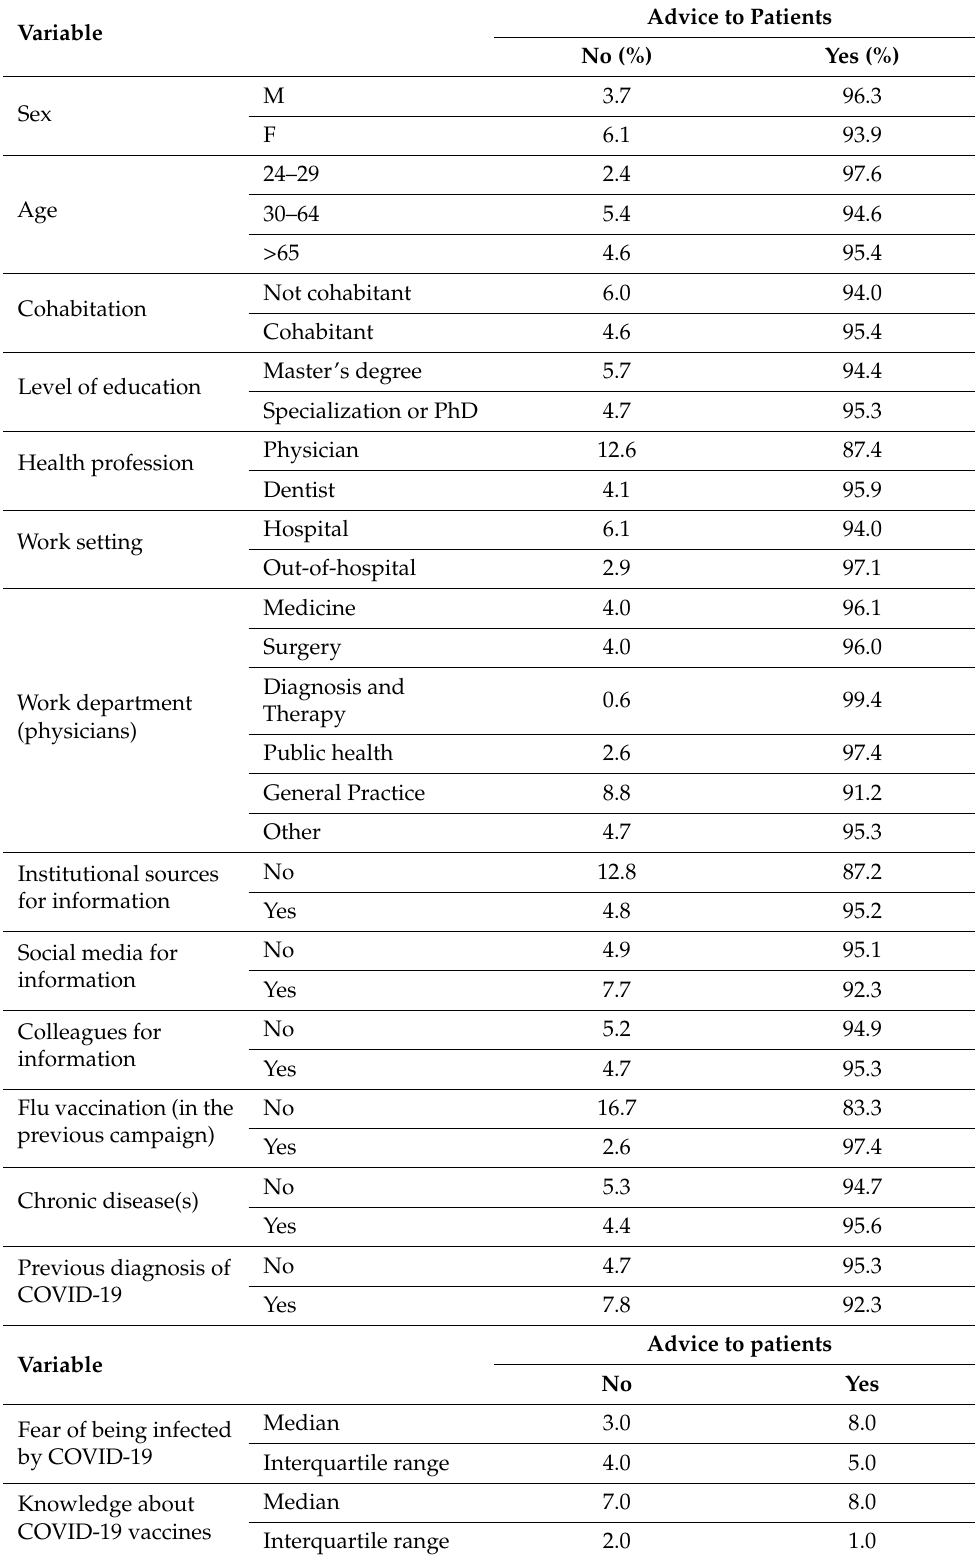
Table 3. Descriptive analysis of the distribution of respondents according to their tendency to recommend vaccination to